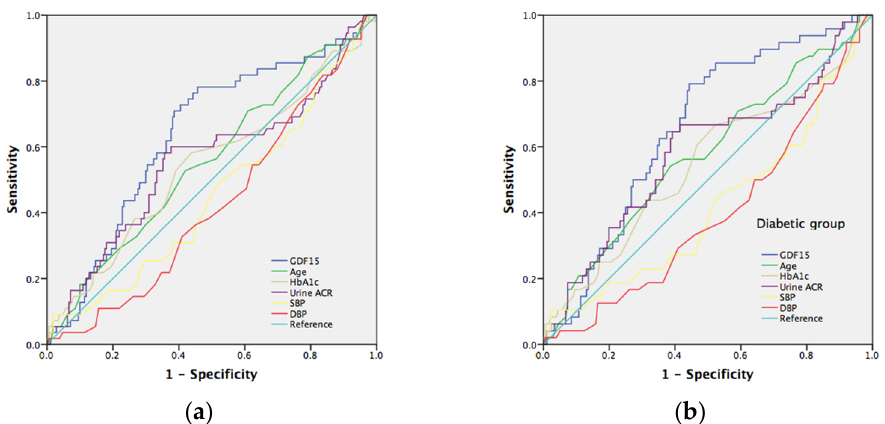
Figure 3. ( a ) Receiver operating characteristic (ROC) curves and area under the curve (AUC) in predicting ulnar nerve sensory neuropathy. Blue line: GDF15 risk score (AUC = 0.639; p = 0.001); green line: age risk model (AUC = 0.557; p = 0.192); yellowish-green line: HbA1c risk model (AUC = 0.545; p = 0.307); purple line: urine albumin/creatine risk model (AUC = 0.557; p = 0.193). Yellowish line: systolic blood pressure risk model (AUC = 0.452; p = 0.272). Red line: urine diastolic blood pressure risk model (AUC = 0.426; p = 0.091); light blue line represents the reference line. ( b ) Receiver operating characteristic (ROC) curves and area under the curve (AUC) in prediction of ulnar nerve sensory neuropathy. Blue line: GDF15 risk score (AUC = 0.658; p = 0.001); green line: age risk model (AUC = 0.576; p = 0.105); yellowish-green line: HbA1c risk model (AUC = 0.545; p = 0.335); purple line: urine albumin/creatine risk model (AUC = 0.582; p = 0.081). Yellowish line: systolic blood pressure risk model (AUC = 0.419; p = 0.086). Red line: urine diastolic blood pressure risk model (AUC = 0.397; p = 0.028); light blue line represents the reference line.